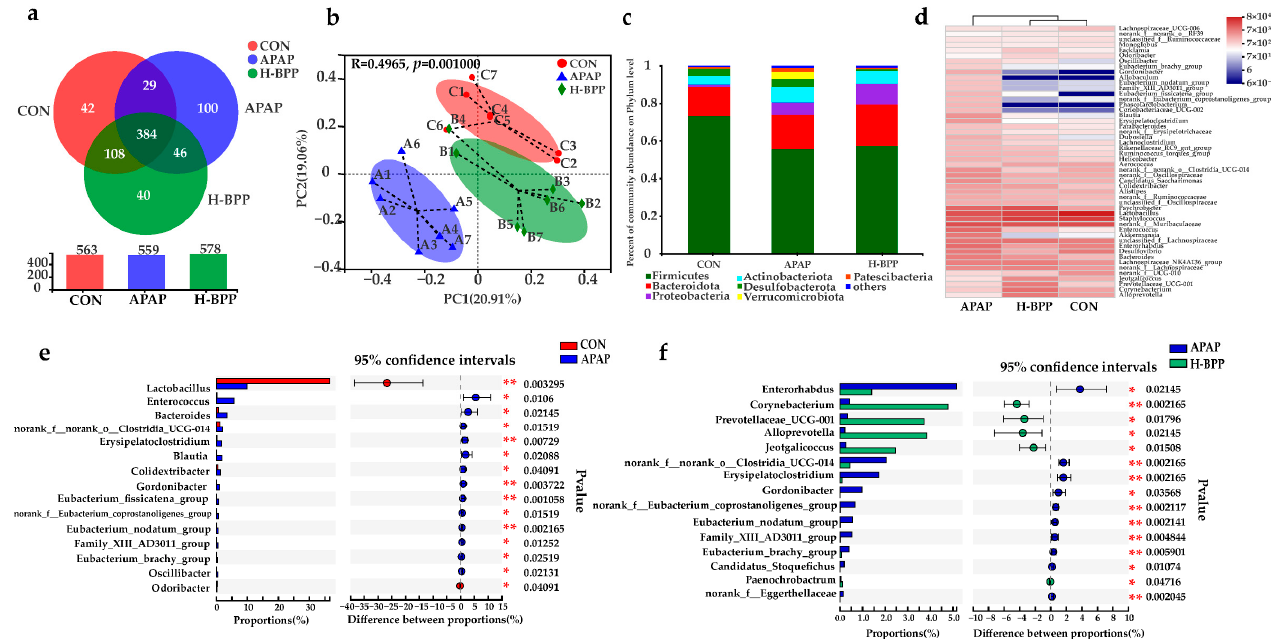
Figure 8. Characteristics of intestinal microbiota in mice after APAP and BPP treatment. ( a ) Species Venn diagram analysis OTU number. ( b ) Principal Component Analysis (PCoA) of gut microbiota at OUTs level. ( c ) Relative abundance of microbiota at the phylum level. ( d ) Relative abundance of microbiota at the genus level. ( e ) Difference of dominant species between CON group and APAP group at genus level. ( f ) Difference of dominant species between APAP group and H ‐ BPP group at genus level. * p < 0.05, ** p < 0.01.